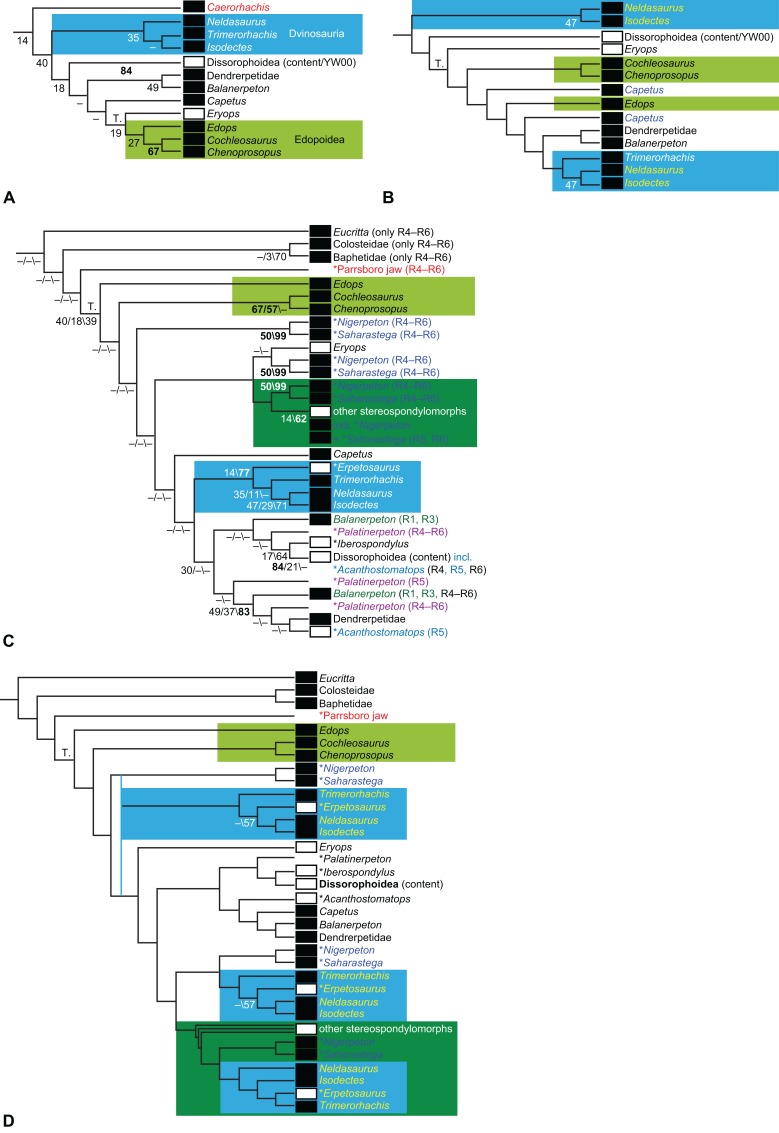
Temnospondyl phylogeny in our analyses, distribution of the intertemporal bone, and the application of the name Temnospondyli.Dissorophoidea and Stereospondylomorpha are collapsed; modern amphibians and various “lepospondyls” (see Fig. 12) are omitted. Filled rectangles indicate presence of the intertemporal (state 0 of ch. 32—PAR 2/POSFRO 3/INTEMP 1/SUTEMP 1), empty rectangles its absence (state 1, or state 2 in the case of *Erpetosaurus; see App. S1); the absence of a rectangle for *Palatinerpeton and the *Parrsboro jaw represents missing data. T., Temnospondyli as defined by Schoch (2013); the entire depicted clade is Temnospondyli as defined by Yates & Warren (2000). (A) Topology found in Analyses R1–R3 (original taxon sample) in MPTs where Temnospondyli is closer to Amniota than Anthracosauria. Only one position of Caerorhachis is shown; the other is far outside Temnospondyli. Numbers are BPO. (B) Additional topologies found in R1 and R3 (original taxon sample) in MPTs where Temnospondyli is closer to Amniota than Anthracosauria. Numbers are BPO of nodes absent from (A). (C) Topologies found in R1 and R3 (original taxon sample) and R4–R6 (expanded taxon sample) in MPTs where Anthracosauria is closer to Amniota than Temnospondyli. Only one position of the *Parrsboro jaw is shown, the other being well outside Temnospondyli. Numbers are BPO/BPE\PP, or BPE\PP where BPO is inapplicable. (D) Additional topologies found in R5 (Fig. 16). Numbers are BPE\PP.